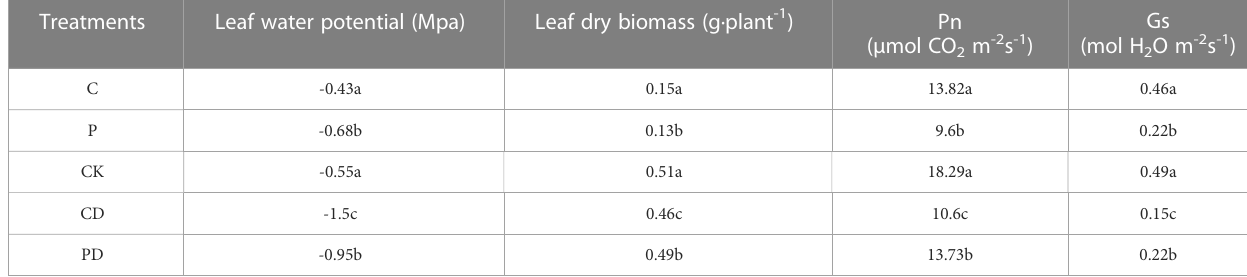
TABLE 1 The leaf water potential, leaf dry biomass, photosynthesis (Pn) and stomatal conductance (Gs) under drought priming and drought stress in wheat." NOTE: C, no drought priming; P, priming; CK, no drought priming + no drought stress; PD, priming + drought stress; CD, no priming + drought